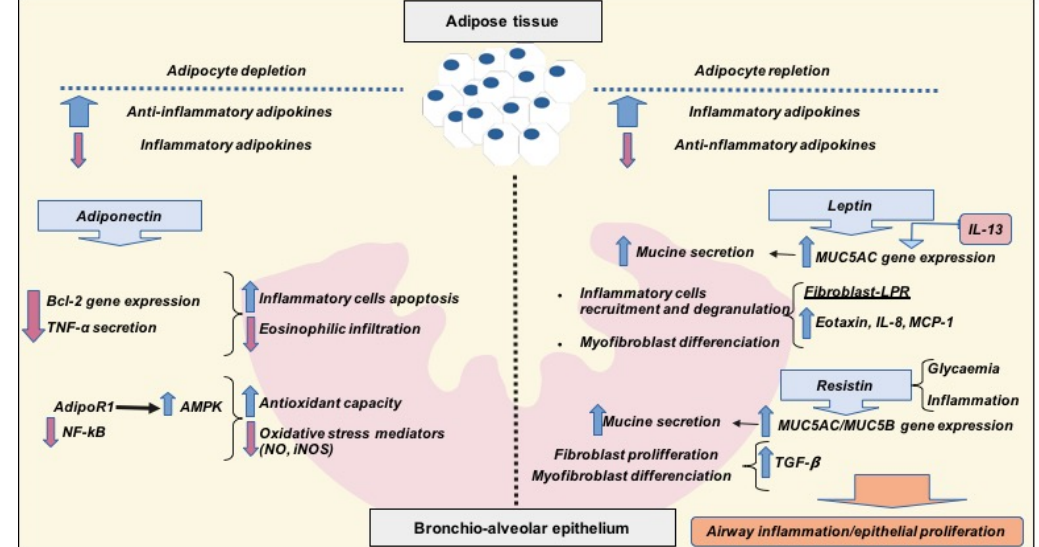
Figure 1. Role of pro-inflammatory and anti-inflammatory adipokines in airway inflammation scheme. Adipocyte depletion is associated with high levels of adiponectin, favoring airway anti-inflammatory status by increasing inflammatory cells’ apoptosis and antioxidant capacity, but decreasing eosinophilic infiltration and reducing the production of oxidative stress mediators. This anti-inflammatory status would be mediated by a downregulation of the inhibitory apoptosis gene Bcl-2, inhibition of TNF-α secretion by airway macrophages and the increment of intracellular AMP-kinase activity through activation of AdipoR1 receptors. A pro-inflammatory cytokine such as leptin is related to obesity and adipocytes’ repletion, whereas resistin levels are increased under high glycaemia and the influence of inflammatory factors. Both leptin and resistin high levels would increase airway mucin secretion through MUC-gene expression, as well as favoring fibroblast proliferation, myofibroblast differentiation and local inflammatory cells’ recruitment through the secretion of pro-inflammatory cytokines (Eotaxin, IL-8, MCP-1 or TGF-β). In this way, high plasmatic levels of leptin and resistin could favor airway inflammation and epithelial remodeling, which are crucial for pulmonary obstructive diseases’ severity and their evolution. Abbreviations: TNF, tumor necrosis factor; NO, nitric oxide; iNOS, inducible nitric oxide synthase isoforms; AmpK, AMP-activated protein kinase; Bcl-2, B-cell lymphoma type 2 gene; NF-kB, nuclear factor kappa-light-chain-enhancer of activated cells; IL, interleukin; MUC5AC Mucin 5AC precursor gene; TGF-β, Tumor growth factor b; MCP-1, Monocyte chemoattractant protein-1.